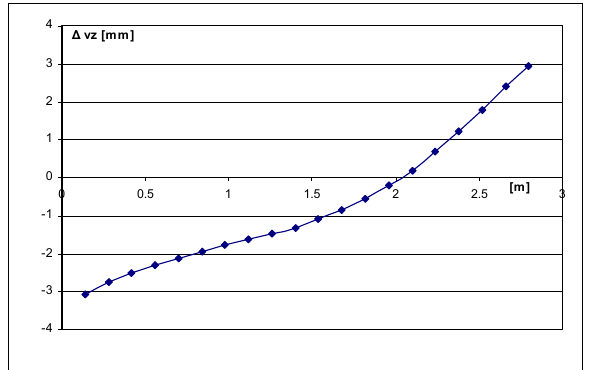
Figure 15: Relative movements Δ vz in the steel/glass connection; abscissa: horizontal extension of the pane; ordinate: relative vertical monements Δ vz in